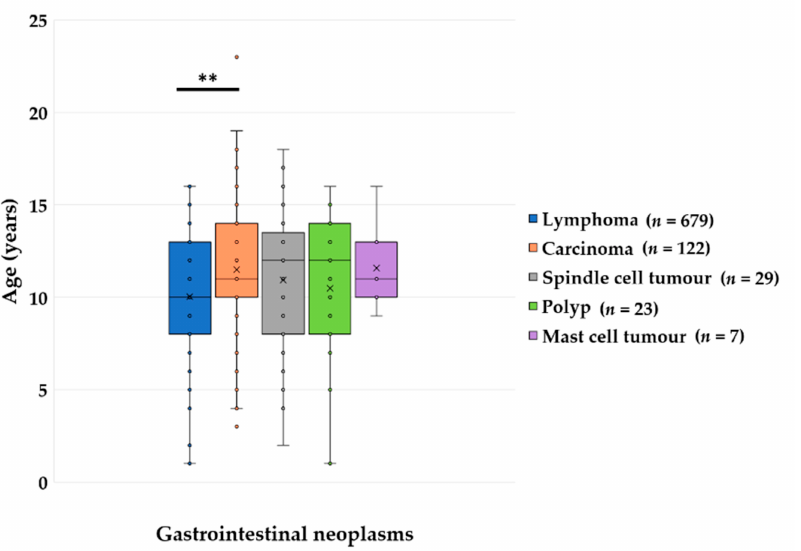
Figure 1. The age of the cats with different gastrointestinal neoplasms and polyps showed a wide variation. Cats with alimentary lymphomas were significantly younger than cats with carcinomas (**, p =